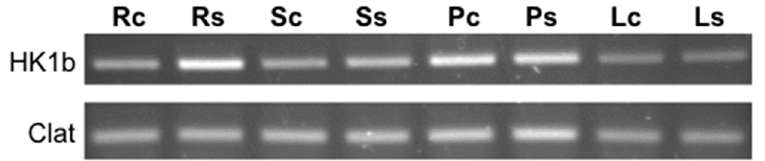
Figure 6. Gene expression of HK1b . HK1b cDNAs were amplified in roots (R), stems (S), petioles (P) and leaf blades (L) in control (c) and stress (s) conditions (PEG 50 g/L). The Clathrine (Clat) gene was used as control.